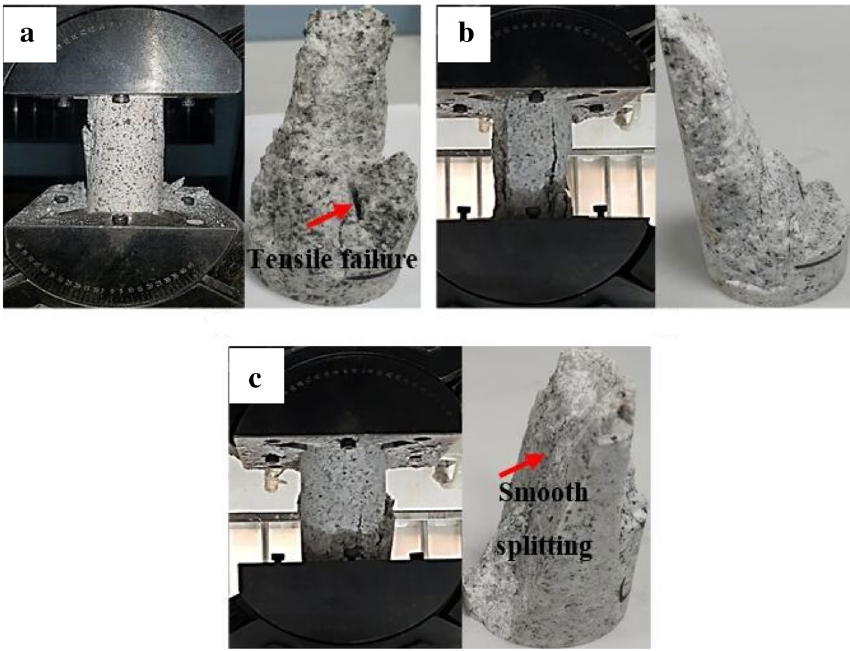
Figure 2. Granite specimen failure patterns under a uniaxial compression state: ( a ) Experimental case 1–1; ( b ) experimental case 1–2; and ( c ) experimental case 1–3.